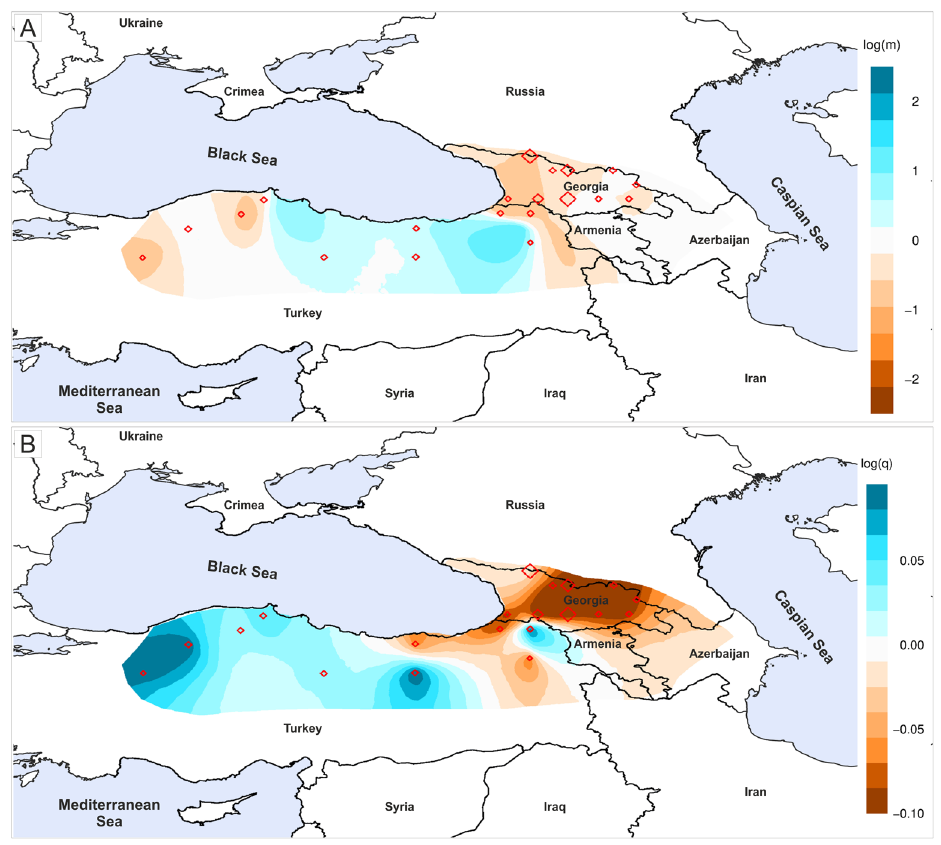
Figure 3. Estimated Effective Migration Surfaces analysis performed for 28 populations of Scots pine in the South Caucasus and the Anatolia based on nuclear microsatellites. ( A ) migration rates among populations, ( B ) diversity rates. The results are presented on a log-scale. Map generated with QGIS 3.16 (https:// qgis. org/ en/